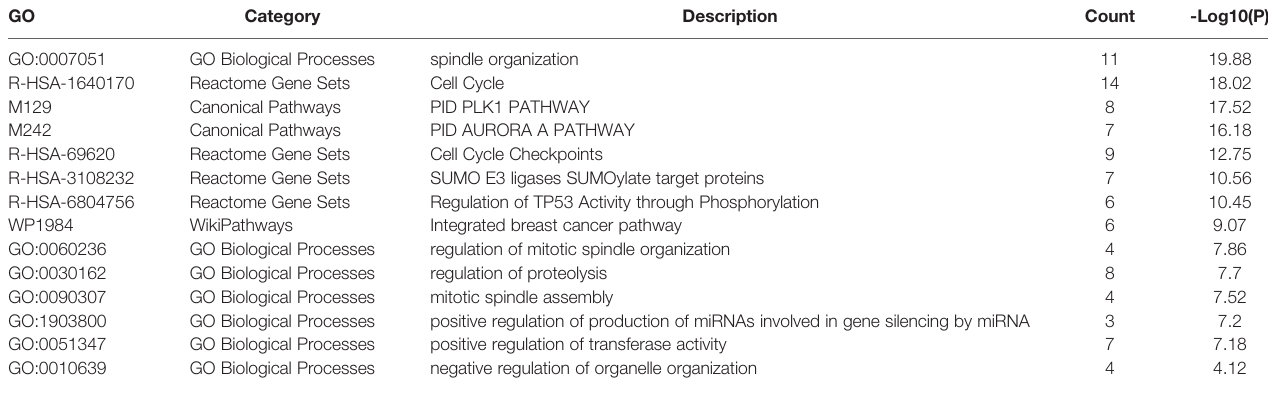
TABLE 3 | Pathway and biological process enrichment analysis of KIF20A and top 20 interacting